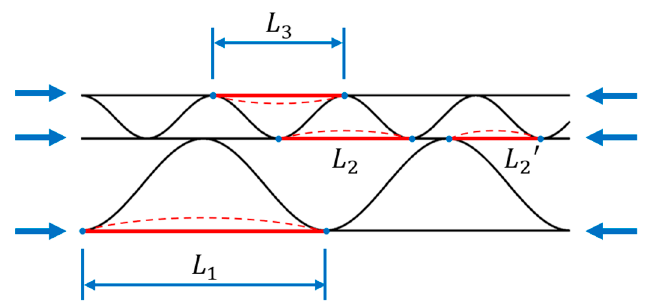
Figure 4. Buckling lengths of corrugated board liners.